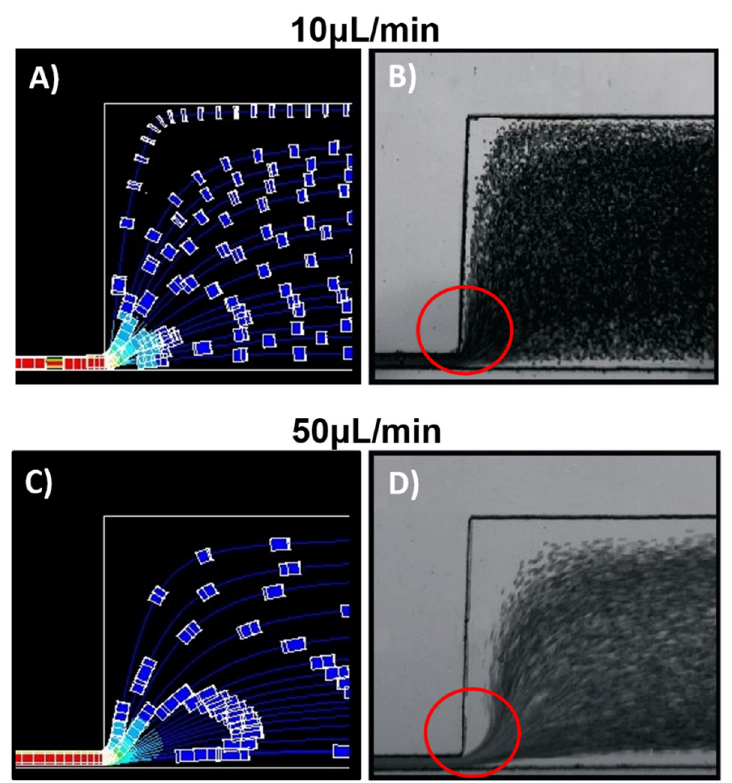
Figure 5. Recorded video images ( B ) (10 μ L/min) and ( D ) (50 μ L/min) show the phosphate-buffered saline (PBS) cell flow suspension at 27 °C. ( A ) and ( C ) are particle suspension simulations at 10 and 50 μ L/min, respectively. The section enclosed in a circle highlights the flow as the red blood cells (RBCs) exit the narrower channel.